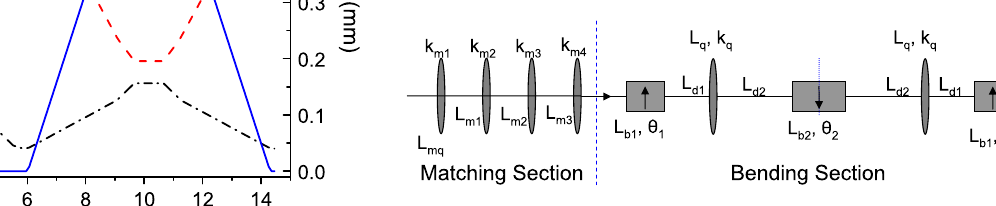
FIG. 6. Simple first order isochronous bend comprised of three dipoles and two quadrupoles. The inner dipole has an opposite sign as compared to the two outer ones. The matching section used to match (cid:4) and (cid:1) according to Eq. (5) is shown in the